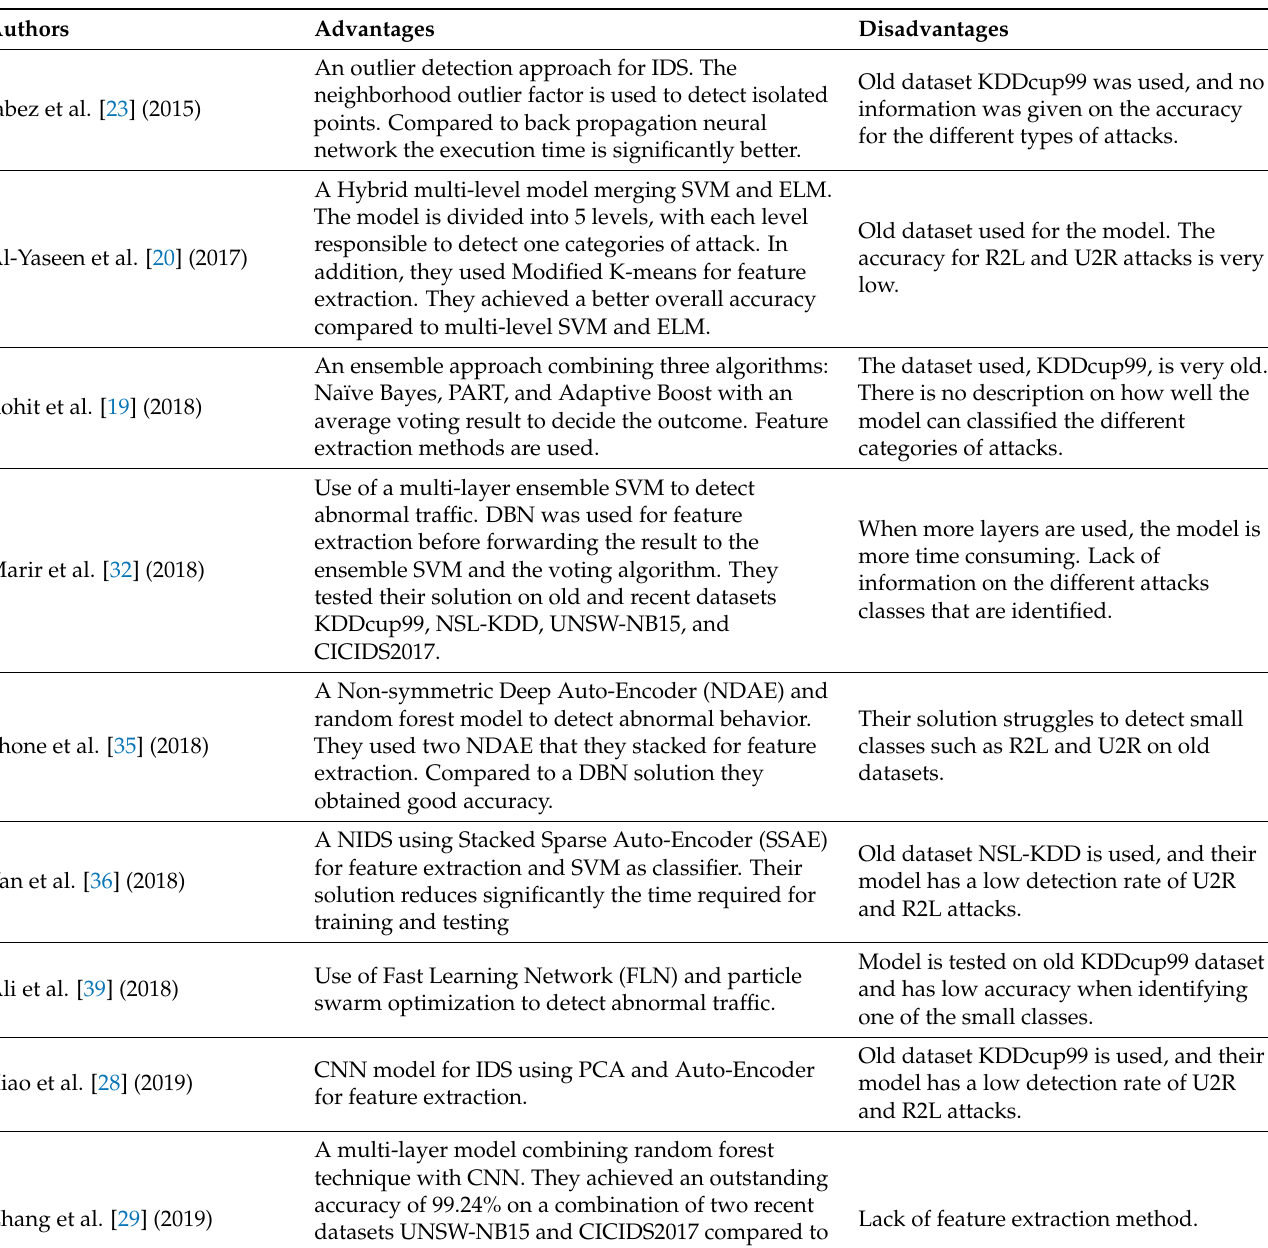
Table 5. Summary of Literature Review (IDS model advantages and